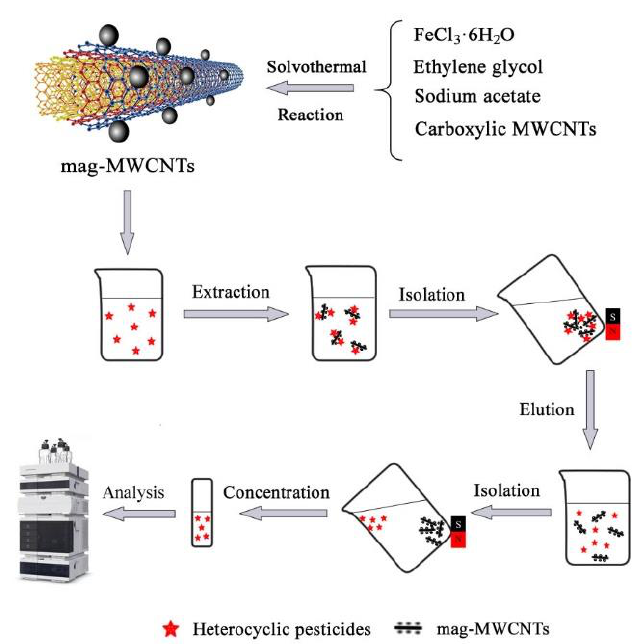
Figure 2. Schematic illustration of the preparation process for the mag-multi-walled carbon nanotubes (mag-MWCNTs) and the magnetic solid-phase extraction (MSPE) procedure.